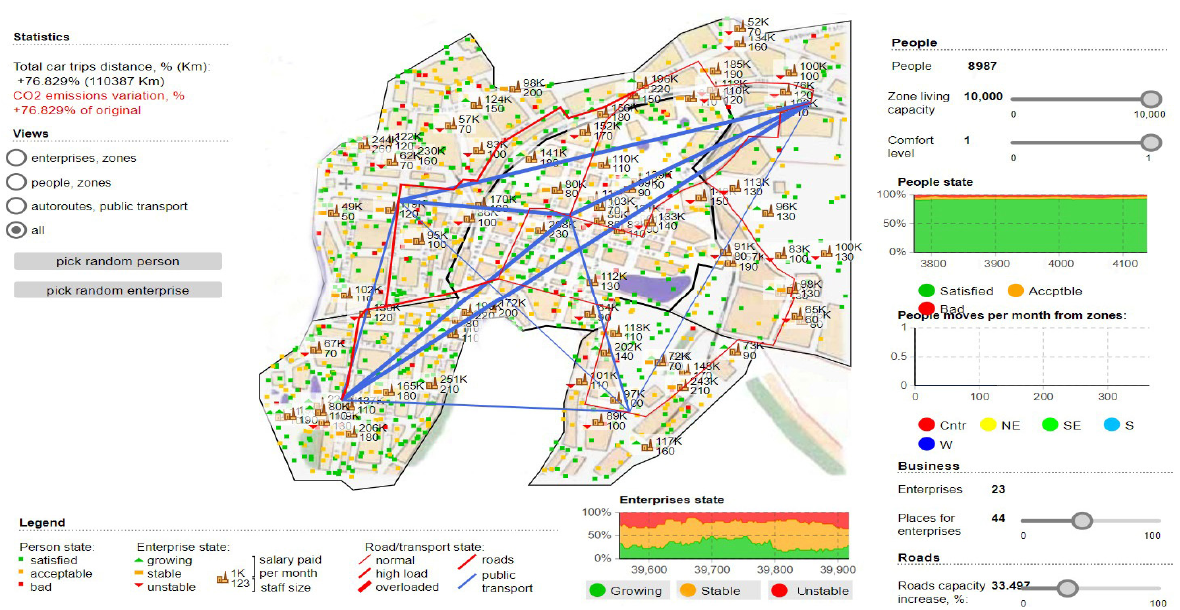
Figure 7. Demonstration scenario showing the contribution brought by the ACO model to the transport network, the exposure of the solutions generated by the algorithm and the distinct high- lighting of the new transit areas with the aim of streamlining traffic and reducing polluting emis-